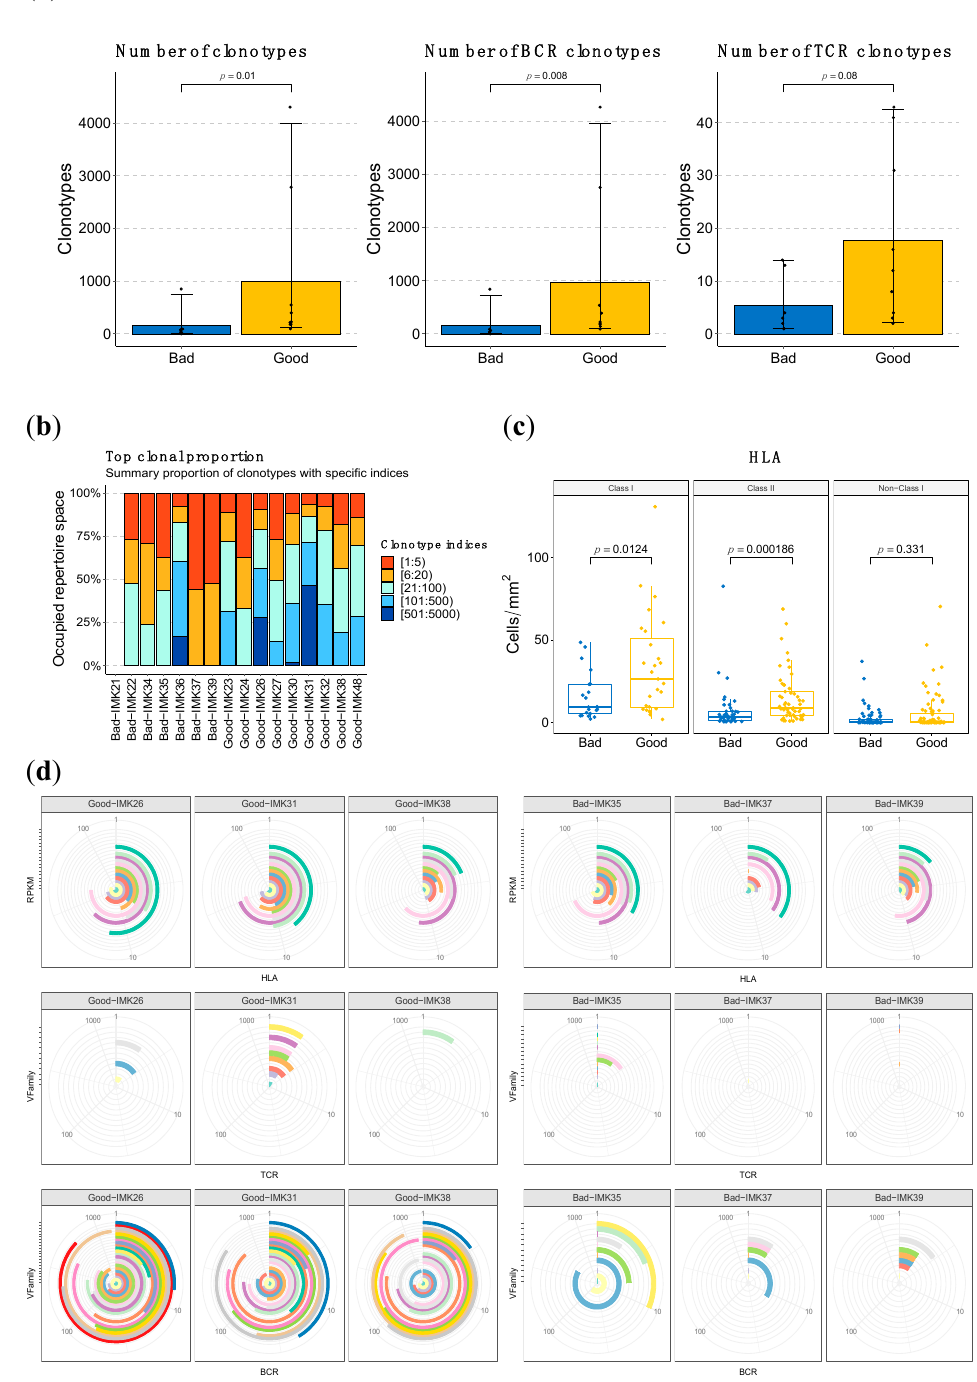
Figure 5. HLA, TCR and BCR abundance and diversity is higher in good responders to Nivolumab. ( a ) Quantification of the sum of BCR and TCR clonotypes in good vs. bad responders and based on the stratification by type of cell. ( b ) Clonal proportion and diversity estimation of clonotypes. ( c ) Quantification of the HLA loci in good vs. bad responders based on type of HLA. ( d ) Representative depictions of the abundance and diversity of HLA, and the VFamily of TCR and BCR clonotypes, based on bulk RNA-seq data. Each concentric circle and color represents a variant, and the covered angle of the circumference indicates the amount of the specific variant.